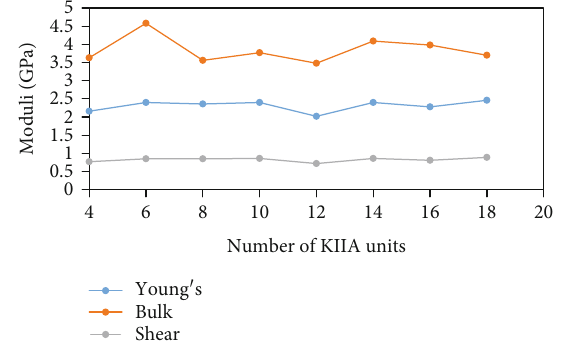
Figure 8: Elastic moduli of kerogen structures, revealing an acceptable degree of reproducibility for kerogen constructed from more than four